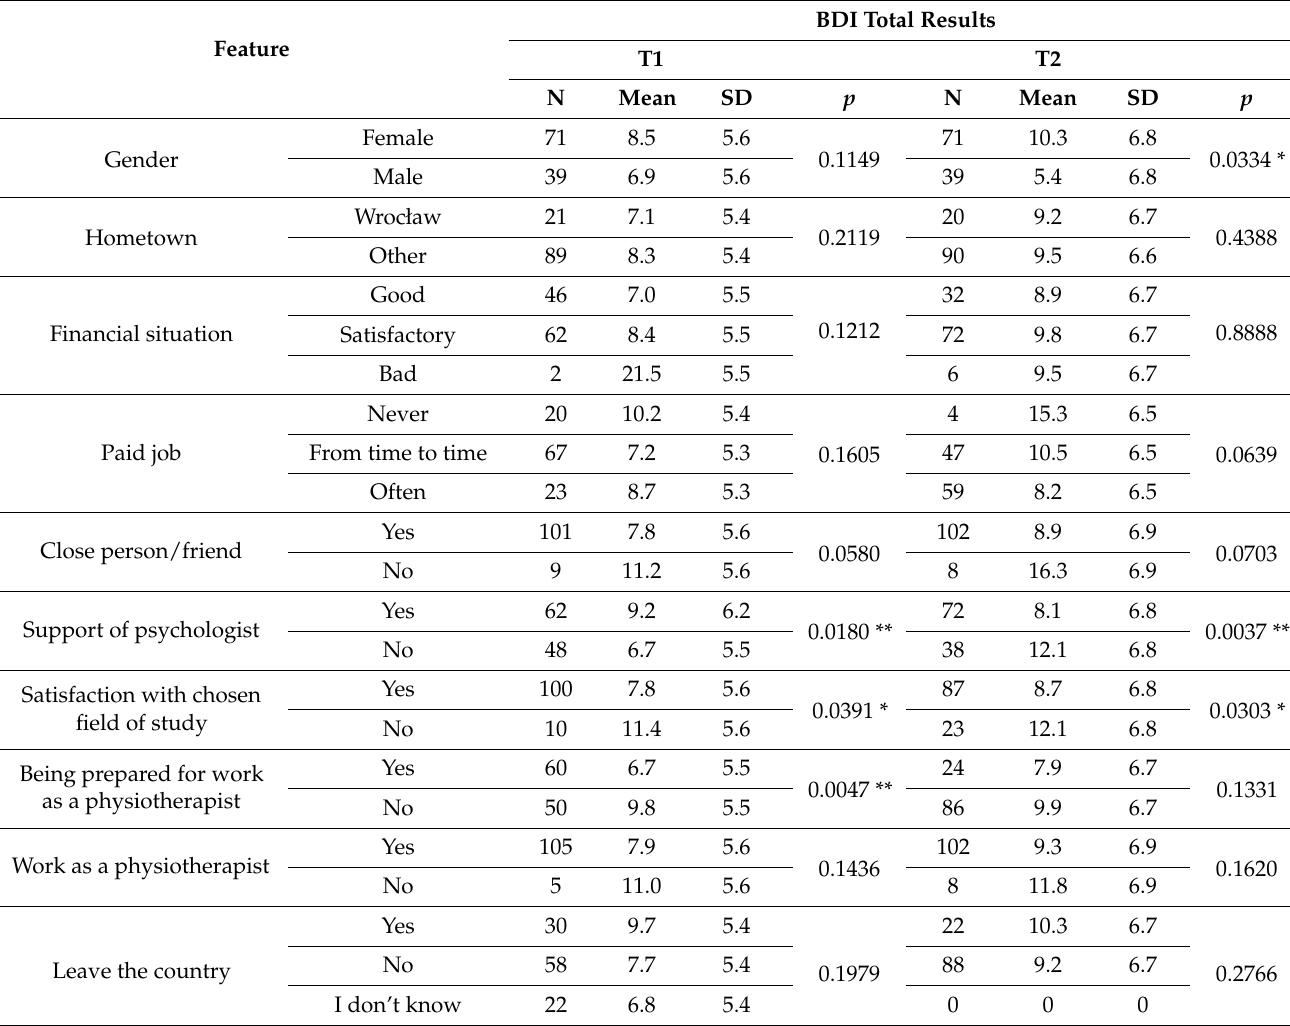
Table 3. Comparison of the initial and final BDI scores between the selected groups of students (Student t -test for independent groups or the ANOVA variance for three groups with at least five